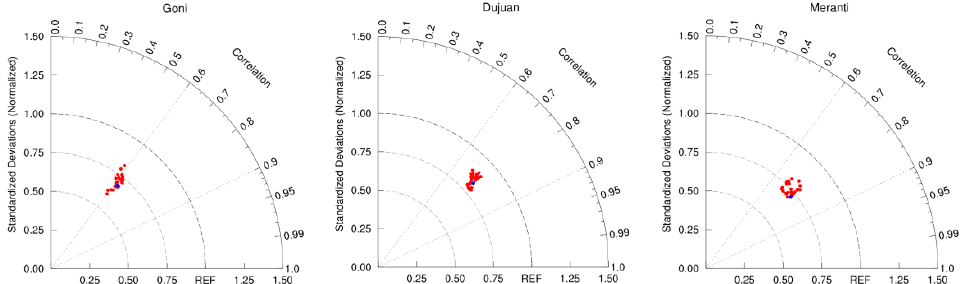
Figure 2. Taylor diagrams of the wind speed for three typhoon events and 27 experiments. Red dots stand for experiments, and blue dots stand for ensemble prediction.